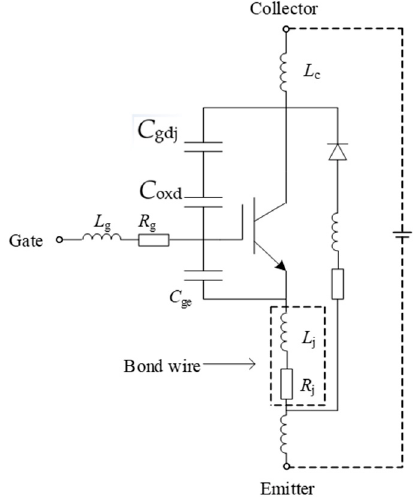
Figure 3. Equivalent circuit diagram of IGBT.